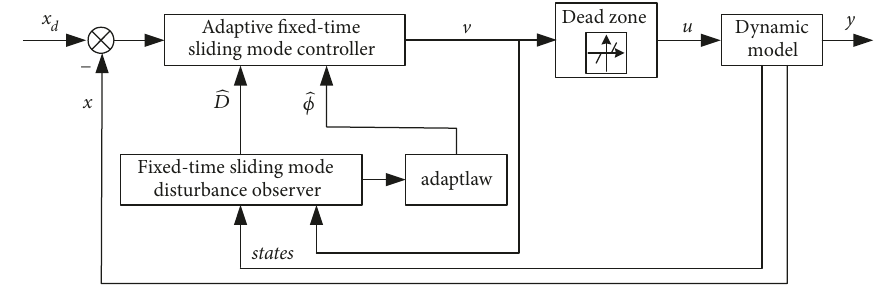
Figure 1: The diagram of controller’s